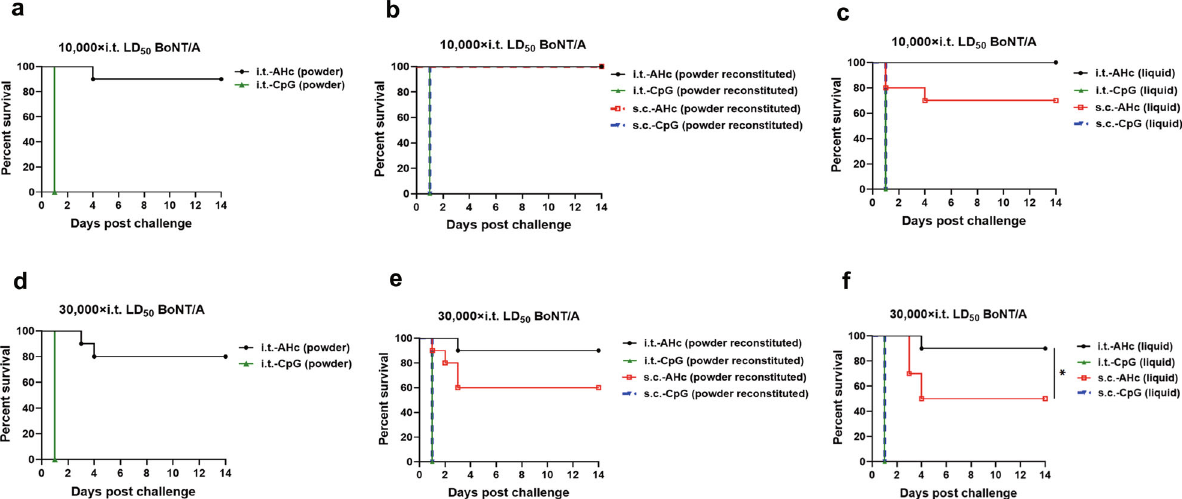
Fig. 4 Protection against a lethal dose of BoNT/A aerosol induced by immunization with AHc vaccines via i.t. inoculation or s.c. injection. Mice were immunized by i.t. inoculation or s.c. injection with AHc vaccines or CpG adjuvants in three formulations three times at 21-day intervals. a , d Dry powder formulation. b , e Reconstituted powder formulation. c , f Liquid formulation. Then mice were challenged with 10,000× i.t. LD 50 ( a – c ) or 30,000× i.t. LD 50 ( d – f ) of BoNT/A in 50 µl of PBS via the i.t. route. Each group consisted of ten mice. The animal survival rate was analyzed by Kaplan – Meier survival analysis. * P < 0.05. Data shown were from one representative experiment with two technical replicates.